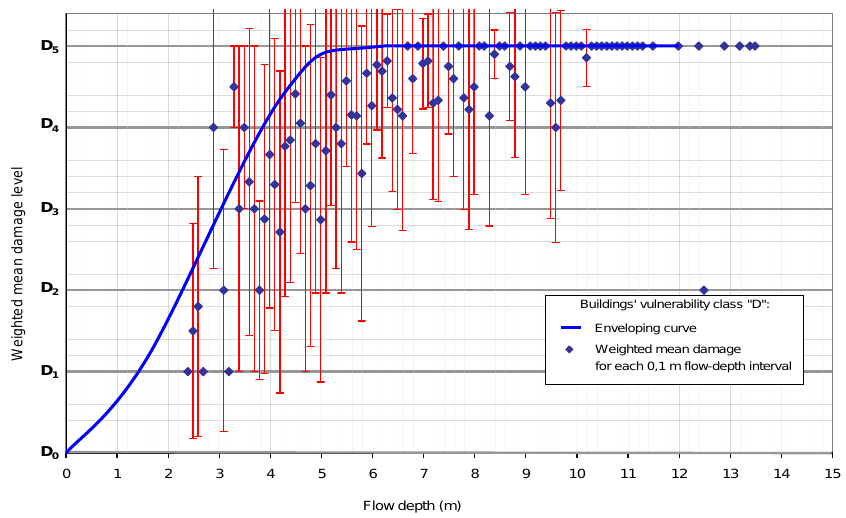
Fig. 9. Enveloping curve for building vulnerability class “D”. Standard deviation for mean damage level ¯ D i is shown with red